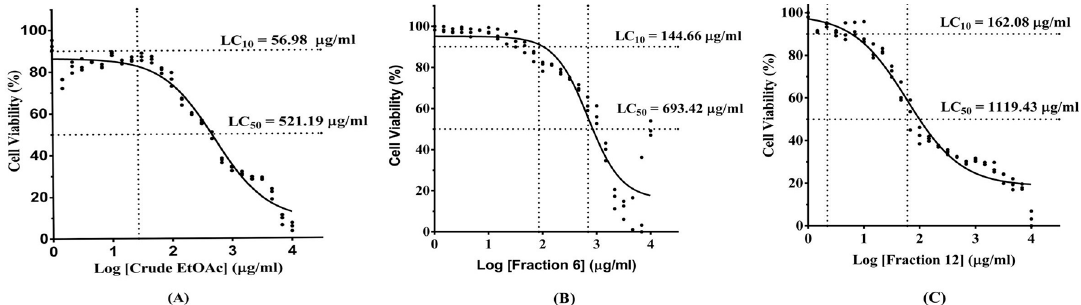
Figure 3. E ff ect of various MO leaves extract concentrations in the neutral red assays. ( A ) Dose–response curve showing 10 lethal concentration (LC 10 ) and median percent lethal concentration (LC 50 ) of crude EtOAc extract, ( B ) Fraction 6, ( C ) Fraction 12.